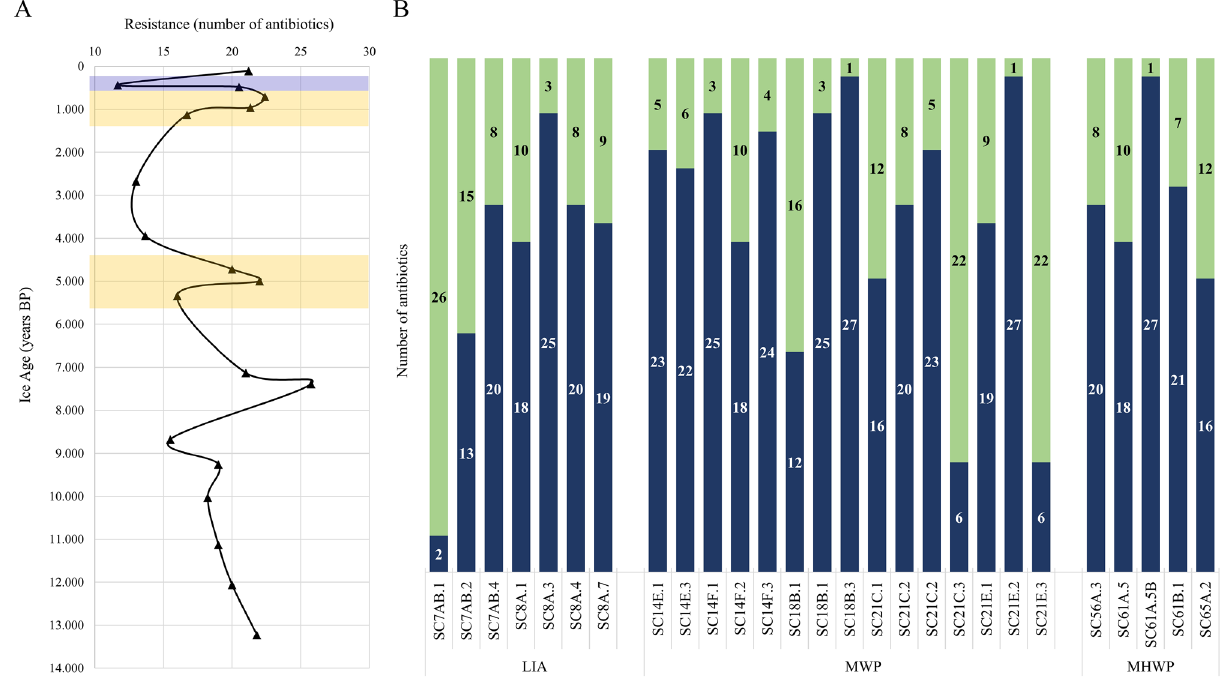
Figure 3. Impact of substrate age and climate during ice deposition on the antimicrobial susceptibility of bacterial isolates from Scarisoara Ice Cave. ( A ) Resistance profile of the cave ice chronosequence. ( B ) Antibiotic resistance (blue) and susceptibility at standard dose (green) to 28 antibiotics (Supplementary Table S3) of cave isolates from ice layers accumulated during Little Ice Age (LIA; 430–475 years BP), Medieval Warm Period (MWP; 953–1124 years BP) and Mid Holocene Warm Period (MHWP; 4751–5335 years BP) (Supplementary Table